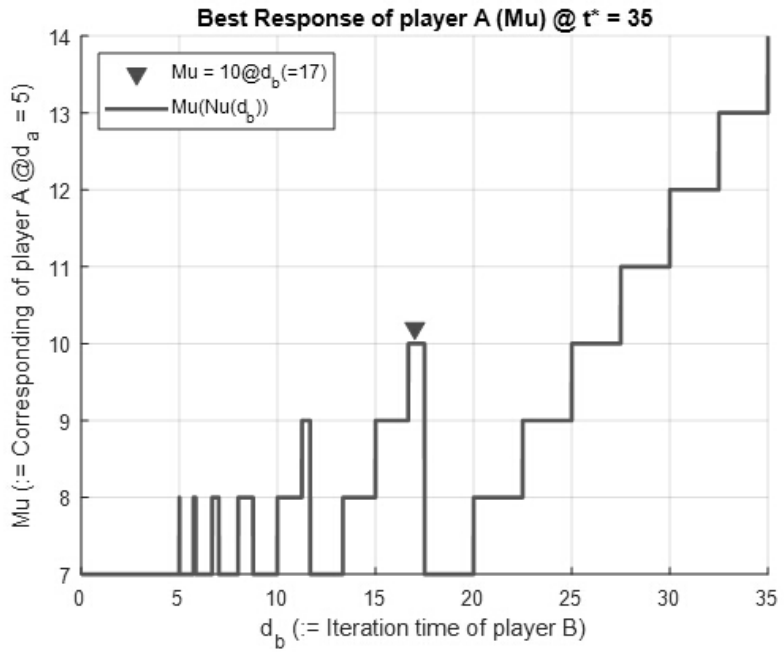
Figure 1. Best response function of Player